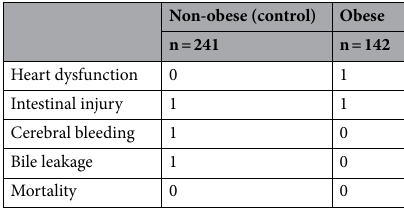
Table 9. Postoperative